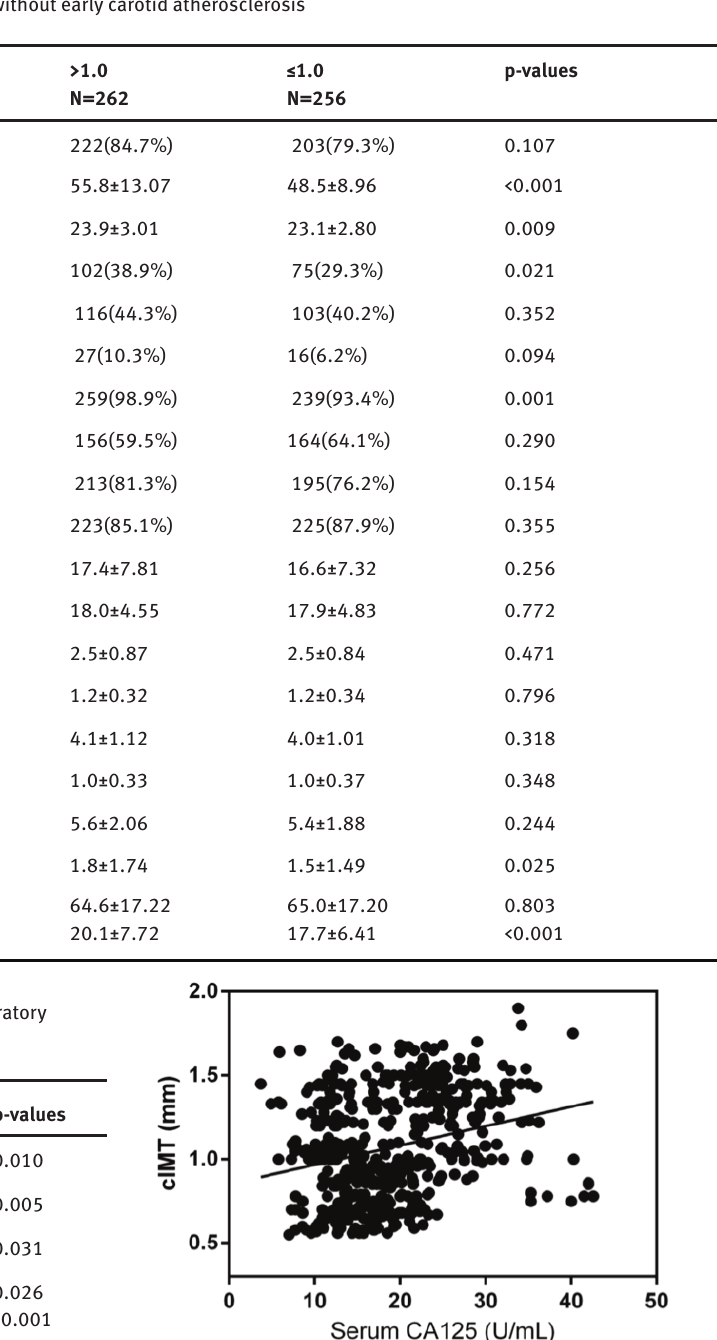
Table 1: Clinical and laboratory parameters in with and without early carotid atherosclerosis